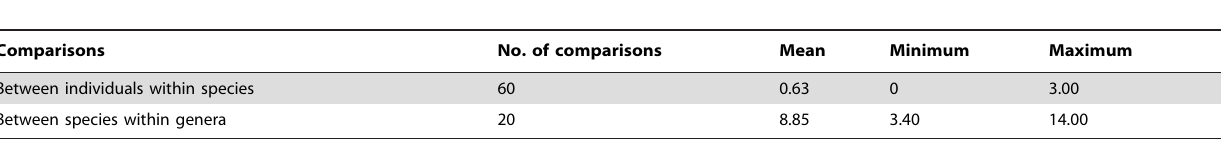
Table 1. Means and ranges of K2P distance values (%) for the COI gene region at different taxonomic levels for the ray species analysed in this